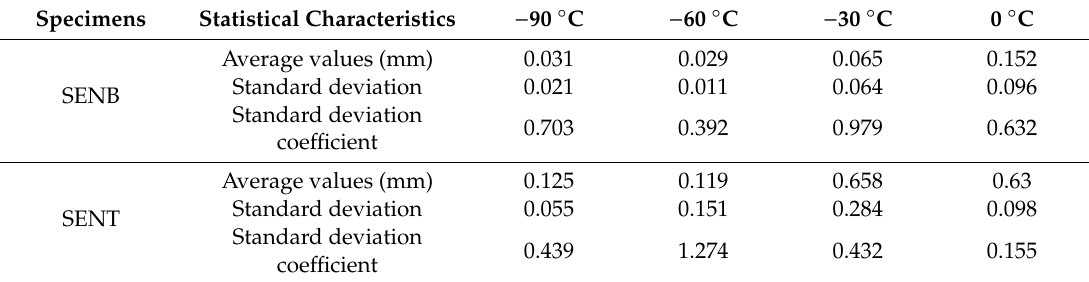
Table 2. Statistical characteristics of test data for SENB and SENT specimens.